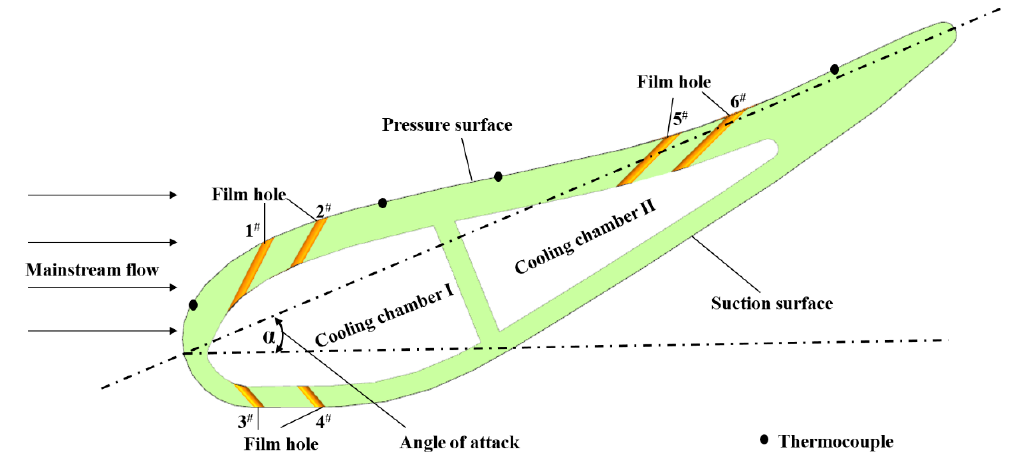
Figure 6. Cross-section details of the test blade.